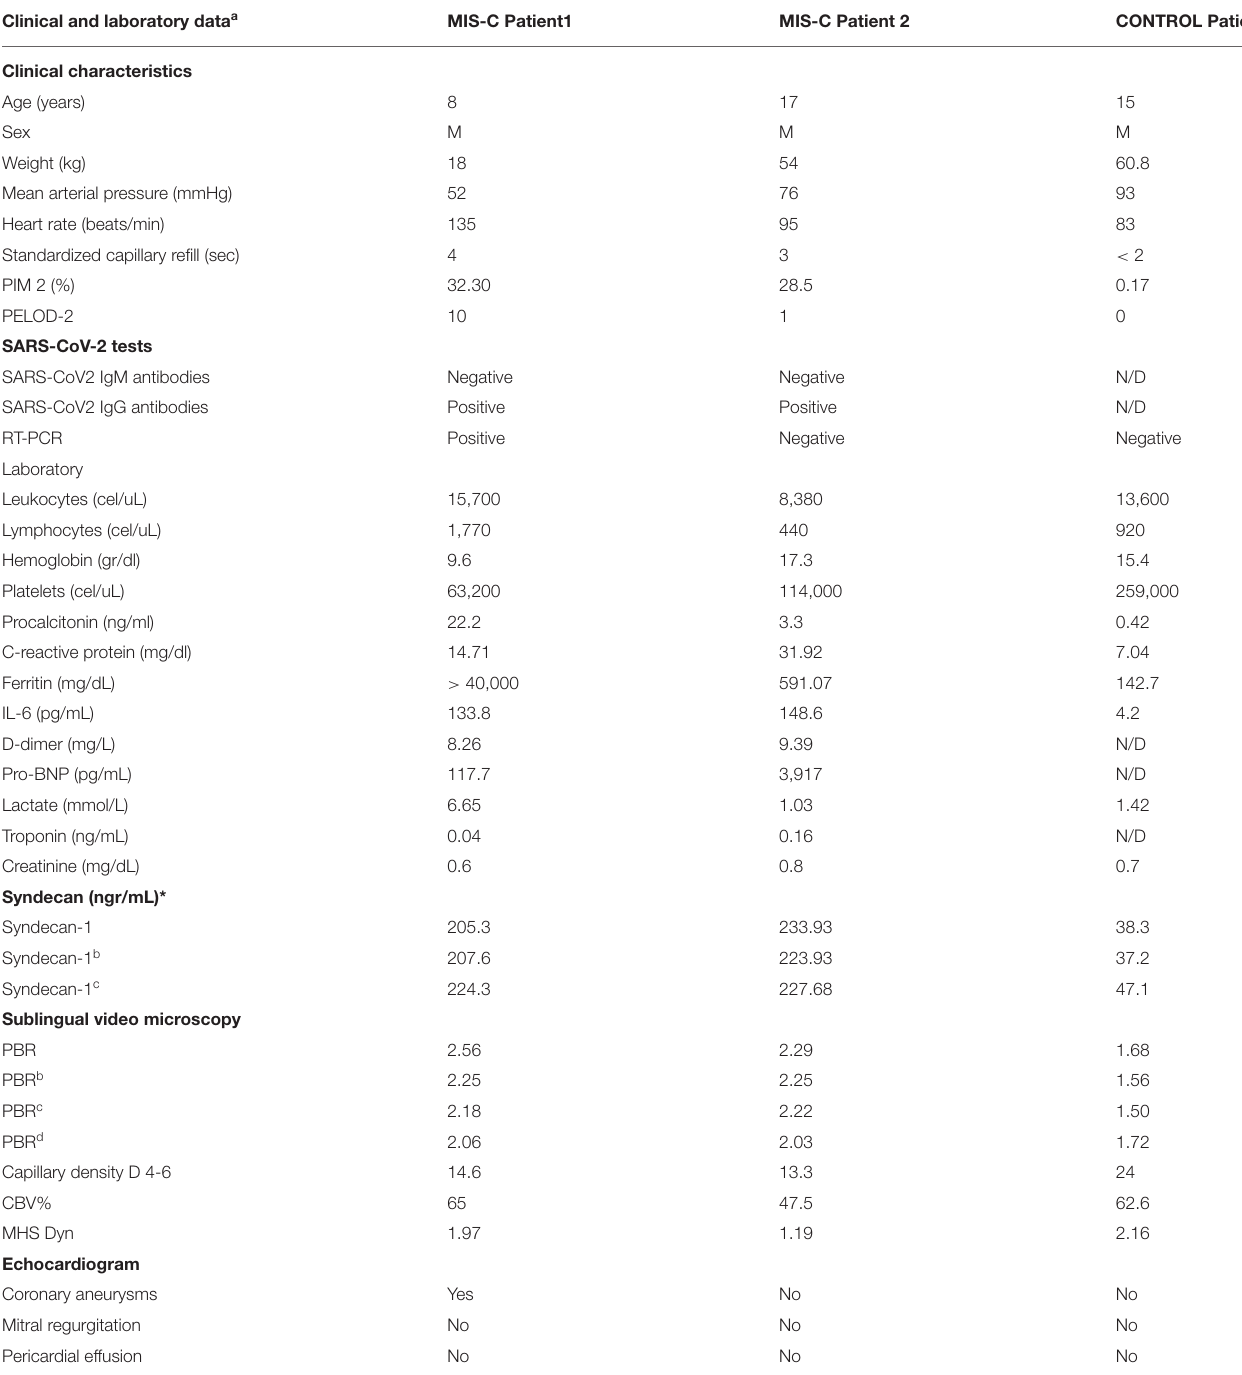
TABLE 1 | Demographic, laboratory and echocardiographic description of patients with MIS-C and endothelial and glycocalyx involvement. Clinical and laboratory data a MIS-C Patient1 MIS-C Patient 2 CONTROL